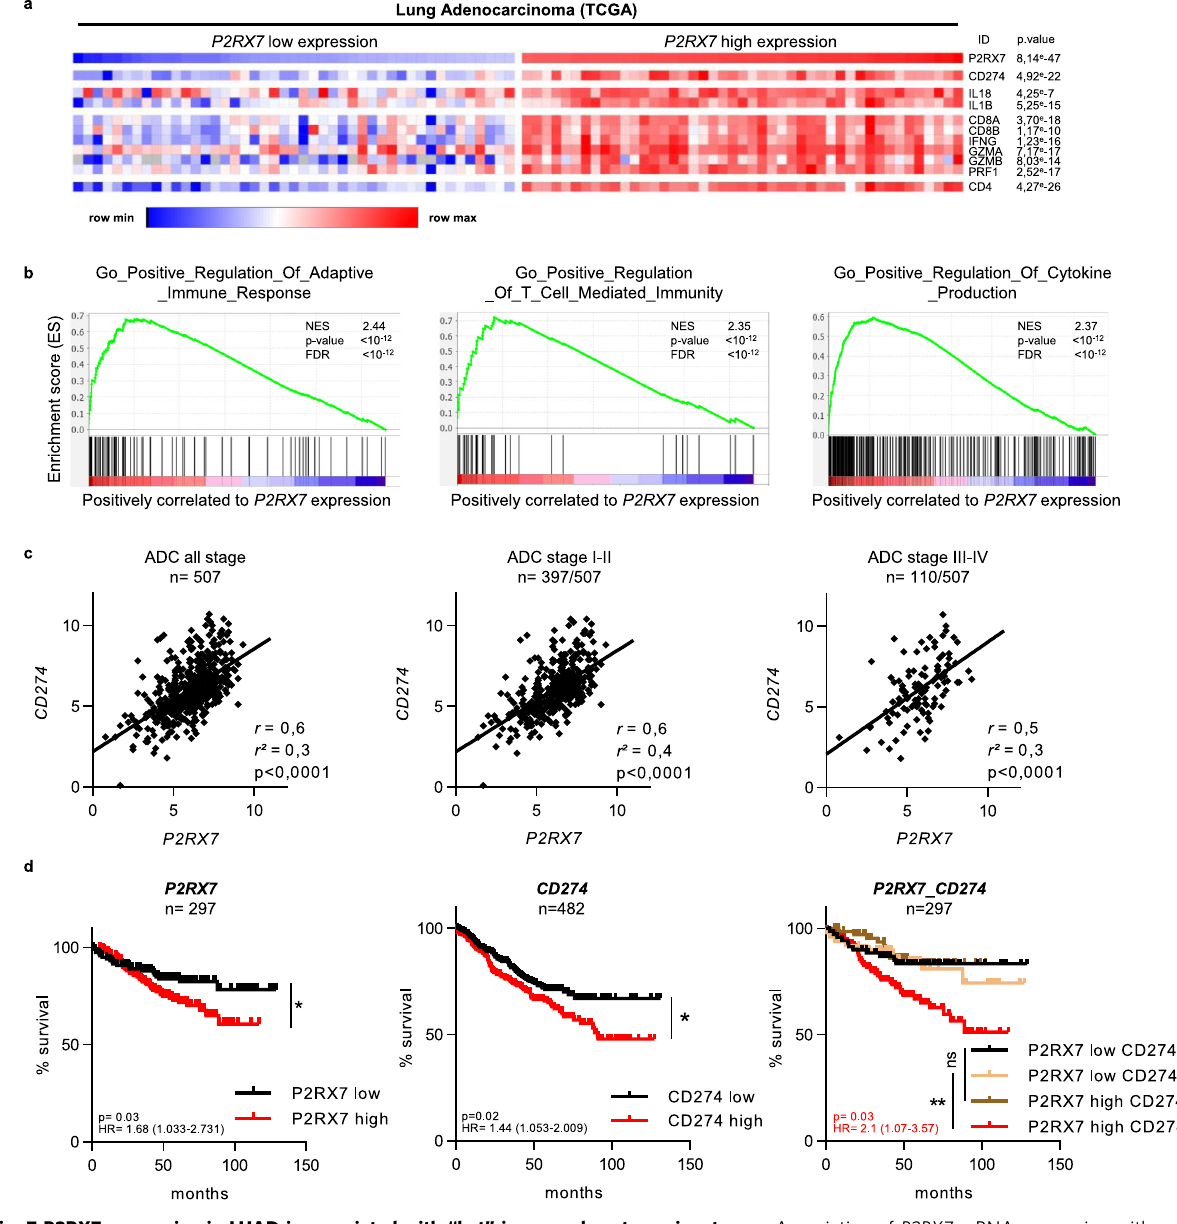
Fig. 7 P2RX7 expression in LUAD is associated with “ hot ” immunophenotype signature. a Association of P2RX7 mRNA expression with a cluster of in fl ammatory genes (heatmap). Expression values are represented as colors, where the range of colors (red, pink, light blue, dark blue) shows the range of expression values (high, moderate, low, lowest). Raw p values (Linear models for microarray analysis, Limma) are shown. b Gene set enrichment analysis (GSEA) plot associating P2RX7 high mRNA levels from LUAD patients (TCGA) with three in fl ammatory signatures. The enrichment score is shown as a green line, and the vertical black bars below the plot indicate the positions of speci fi c in fl ammatory signature-associated genes, which are mostly grouped in the fraction of upregulated genes. For each signature, normalized enriched score (NES), p values (bilateral Kolmogorov – Smirnov), and false discovery rate (FDR) are shown. c . Correlation curves of P2RX7 and CD274 expression from LUAD patients (TCGA) of all stage (left panel), low stage (middle panel), and high stage (right panel). r , r 2 , and p values are shown in each panel, (Person correlation and t test). d Kaplan – Meyer plot (http://kmplot.com) showing survival curves of P2RX7 high vs. P2RX7 low patients (left panel), CD274 high vs. CD274 low (middle panel), and P2RX7 high or low vs. CD274 high or low (right panel). For all panels, the optimal cutoff is determined on KMplot. The p value (log-rank, Mantel Cox test), the hazard ratio, and number of patients are indicated. Source data are provided as a Source Data fi le. ADC adenocarcinoma, HR hazard